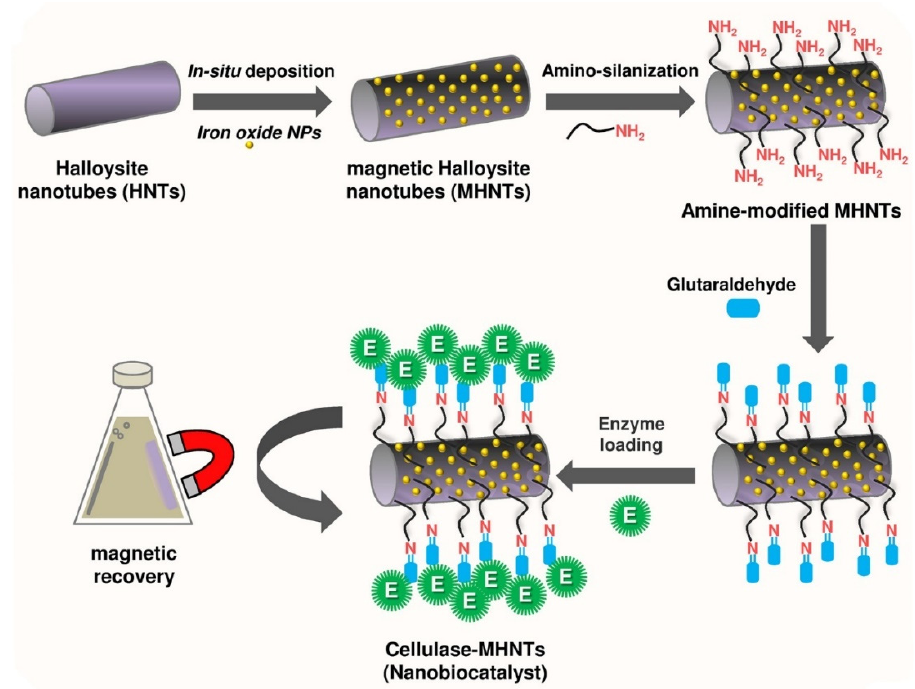
Figure 8. Representative illustration for immobilizing cellulase enzyme on to halloysite nanotubes as a template/matrix using aminosilane as a cross-linker. Prior to this, iron oxide nanoparticles were synthesized over halloysite nanotubes concurrent with their deposition, rendering the nanobiocatalyst recoverable using a magnet. Reproduced with permission from [120], American Chemical Society, 2020.